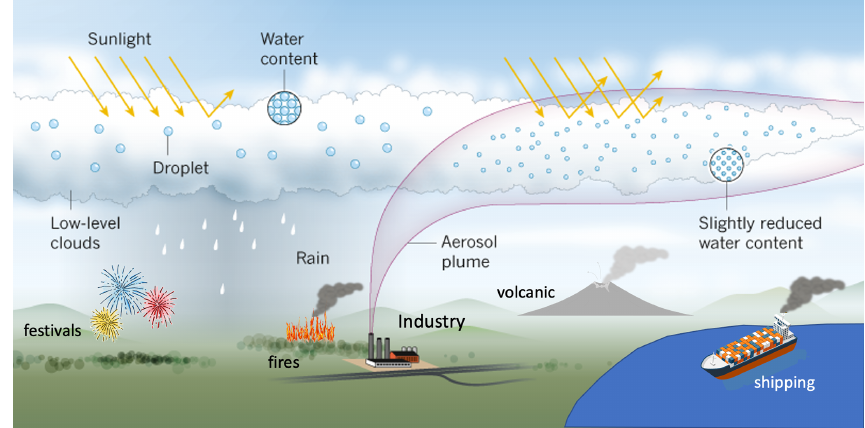
Figure 1. Schematic showing examples of the aerosol effect on boundary layer liquid clouds from some prominent natural laboratories found over the globe. Figure was adapted from Possner